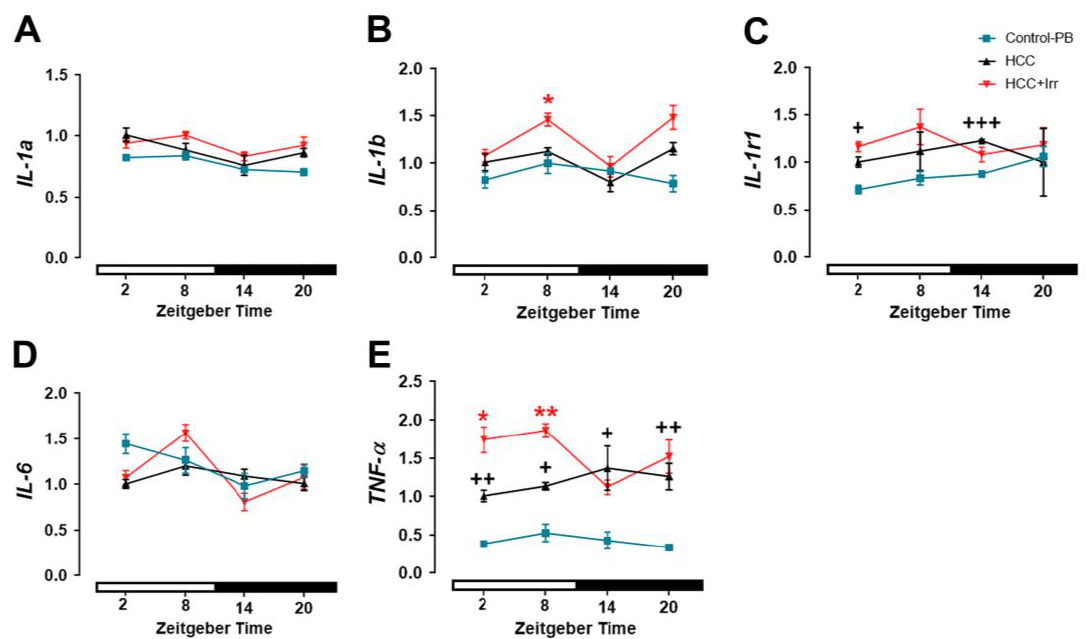
Figure 1. Effect of hepatocellular carcinoma (HCC) and radiotherapy on the relative expression of genes encoding for pro-inflammatory cytokines in the mouse hippocampus. ( A ) Relative expression of IL-1a mRNA. ( B ) Relative expression of IL-1b mRNA. ( C ) Relative expression of IL-1r1 mRNA. ( D ) Relative expression of IL-6 mRNA. ( E ) Relative expression of TNF- α mRNA. Black crosses indicate differences between HCC mice and control-PB. Red asterisks indicate differences between HCC and HCC+Irr. *, +: p < 0.05, **, ++: p < 0.01, +++: p < 0.001. White and black bars indicate the day/rest phase and night/activity phase, respectively. n = 12 mice per group, 3 mice at each time point. Control-PB: control mice given phenobarbital (PB) in drinking water. HCC: HCC-bearing mice. HCC+Irr: HCC-bearing irradiated mice. Interleukin ( IL ). Interleukin-1 receptor ( IL-1r1). Tumor necrosis factor alpha ( TNF- α